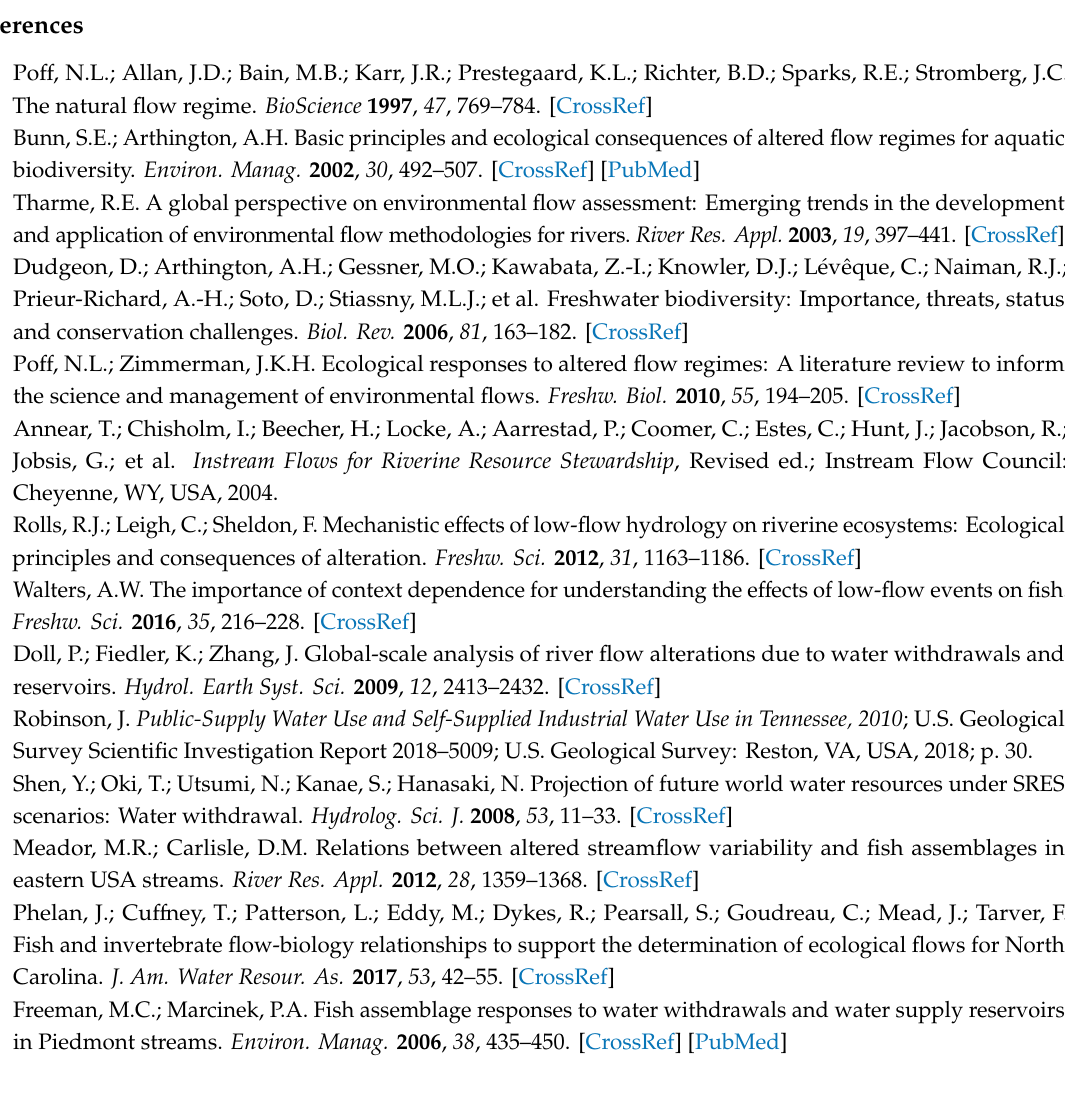
(CR) withdrawals, Figure S12: Predicted percent-change (%) in fish species richness among Interior Plateau (CP) streams to constant-rate (CR) withdrawals, Figure S13: Predicted percent-change (%) in fish species richness among Blue Ridge (BR) streams to percent-of-flow (POF) withdrawals, Figure S14: Predicted percent-change (%) in fish species richness among Ridge and Valley (RV) streams to percent-of-flow (POF) withdrawals, Figure S15: Predicted percent-change (%) in fish species richness among Cumberland Plateau (CP) streams to percent-of-flow (POF) withdrawals, Figure S16: Predicted percent-change (%) in fish species richness among Interior Plateau (CP) streams to percent-of-flow (POF) withdrawals, Figure S17: Boxplots of predicted ecological withdrawal thresholds under constant-rate (CR) withdrawals, Figure S18: Boxplots of predicted ecological withdrawal thresholds under percent-of-flow (POF)